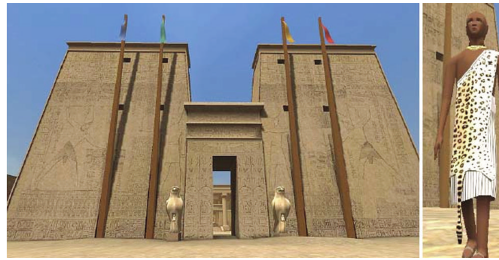
Figure 5: Egyptian virtual temple [21].